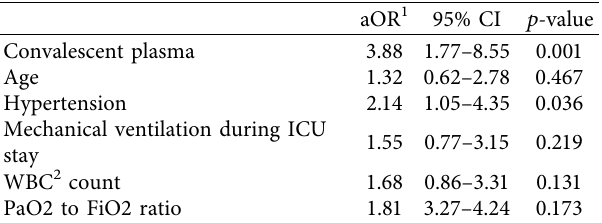
Table 4: Multivariate analysis on factors confounding prolonged ICU length of stay.